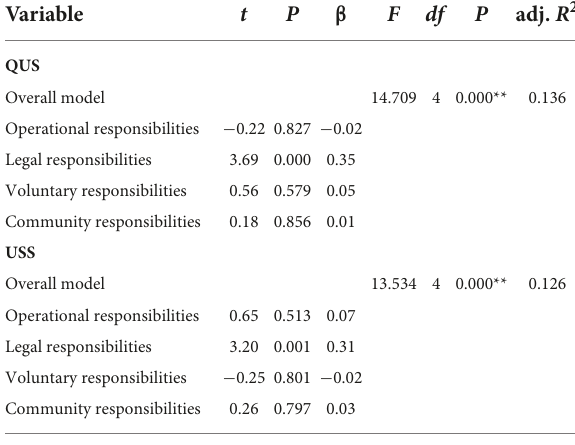
TABLE 6 Multiple linear regression analysis for QUS and USS.